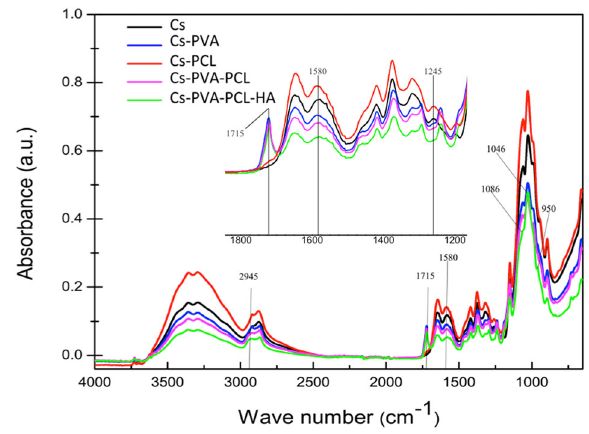
Fig. 3 FTIR spectra of